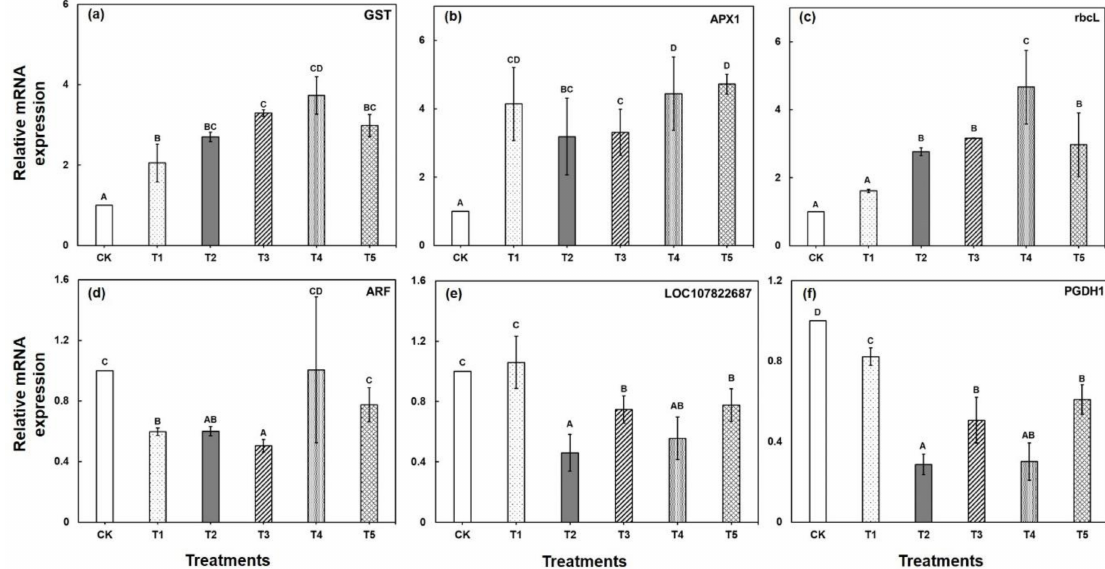
Figure 7. qRT-PCR validation of gene expression patterns in Brassica seedling leaves under CA-mediated Cu stress that correspond to six differentially abundant proteins. The subfigure ( a – c ) represents the up-regulated proteins corresponds to glutathione S-transferase U20, L-ascorbate peroxidase 1, and ribulose bisphosphate carboxylase large chain respectively; and ( d – f ) represents the down-regulated proteins corresponds to carbonic anhydrase, D-3-phosphoglycerate dehydrogenase 1, and ADP-ribosylation factor 2 respectively. Each value represents the mean of three replicates ± SE. Different letters indicate significant differences at p < 0.05 among treatments by Tukey’s